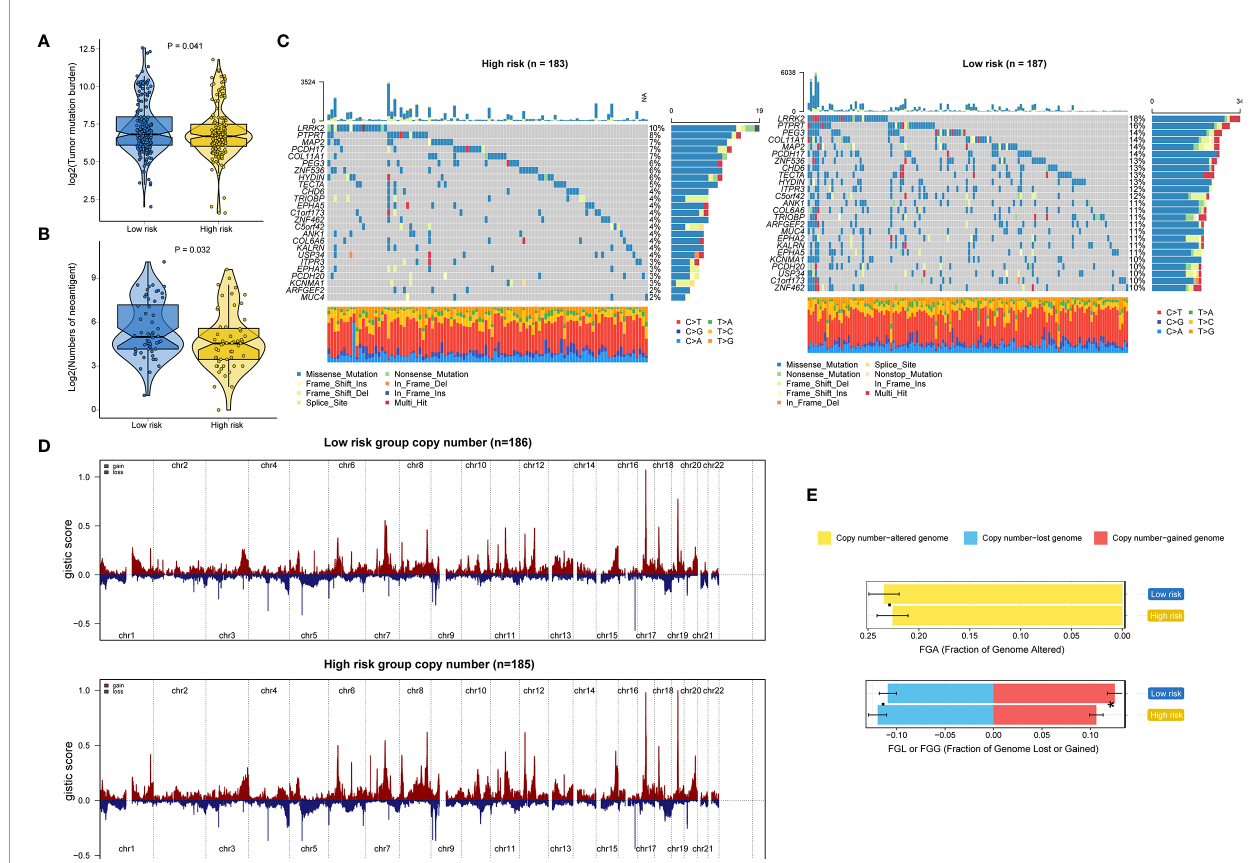
FIGURE 6 | Identi fi cation of genetic variants underlying the RNA processing-related prognostic signature. (A) Violin plot for the TMB between the low-risk and high- risk groups. (B) Violin plot for the number of neoantigens between the lower-risk and higher-risk groups. (C) Waterfall plot of the top 25 mutant genes in the low-risk and high-risk groups. (D) SCNA pro fi les with gains (red) and losses (blue) between the lower-risk and higher-risk groups. (E) Differential analysis of the fraction (%) of the genome altered, lost, and gained between the lower-risk and higher-risk groups. P values were obtained by the Mann-Whitney test. The asterisks represented the statistical P-value (*P <